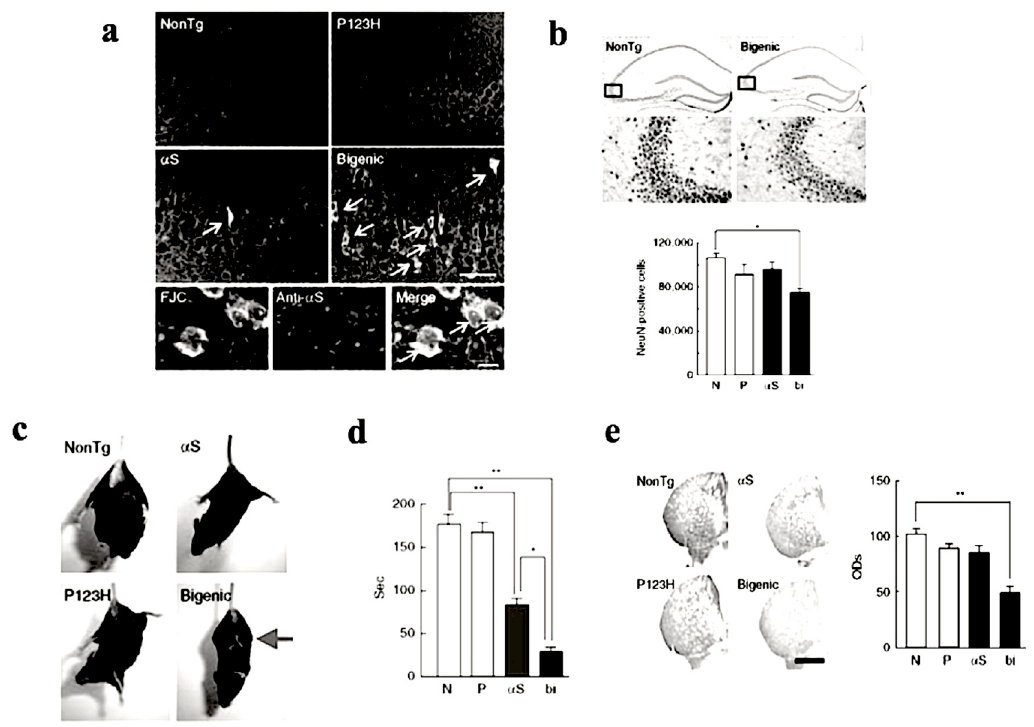
Figure 3. Increased nerodegeneration phenotype in bigenic (P123H β S X α S) mice. ( a ) Evaluation of neurodegeneration by Fluoro-Jade C (FJC) staining. Representative images of the hippocampus from bigenic mice and from other littermates are shown (four figures in the upper panel). FJC-positive cells were observed in bigenic mice and to a lesser extent in α S tg mice (arrows). Scale bar = 50 µ m. Lower images show that FJC-stained cells were also positive for α S (arrows) in bigenic mice. Nuclei were simultaneously stained with DAPI (4,6-diamidino-2-phenylindole). Scale bar = 10 µ m. ( b ) Left panels: representative images of NeuN of the hippocampus from bigenic mice and NonTg littermates are shown. Scale bar = 500 µ m (upper two panels) or 100 µ m (lower two panels). The figures given in the lower panels are magnifications of the figures given in the upper panel. Right panels: The graph shows neuronal density based on the NeuN-immunoreactive cell count (cells mm − 3 ) in the hippocampus. Data are shown as mean ± SEM ( n = 5). * p < 0.05 versus non-tg mice. ( c ) A representative photograph of the tail-suspension assay shows at 4 mo strong front and hind limb clasping in bigenic mice (arrow), but not in other littermates. ( d ) Rota-rod treadmill test shows impaired motor performance in bigenic mice and to a lesser extent in α S tg mice. Data are shown as mean ± SEM ( n = 9–18). * p < 0.05, ** p < 0.01. ( e ) Left panels: representative images of TH immunohistochemistry at striata from 7 month bigenic mice and littermates (P123H β S tg, α S tg and non-tg) are shown. Scale bar = 500 µ m. Right panels: The average optical densities (ODs) of the TH immunoreactivity was measured. Data are shown as mean ± SEM ( n = 8). ** p < 0.01 versus non-tg mice. Reprinted with permission from reference [14].